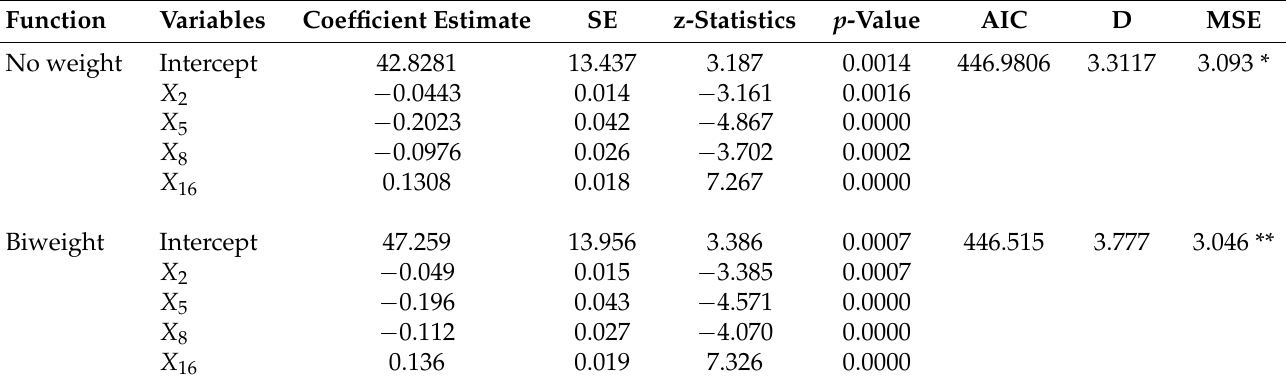
Table 6. AIC, BIC, D, and MSE of the Model VI based biweight